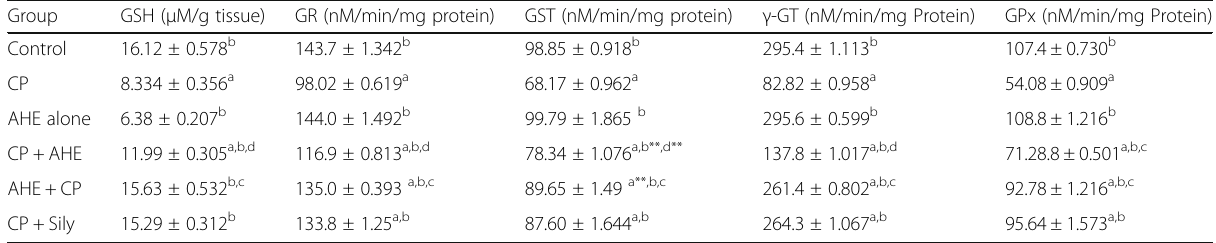
Table 2 Effect of cisplatin (CP) and different treatments of AHE on lungs tissue antioxidant enzymes and GSH profile